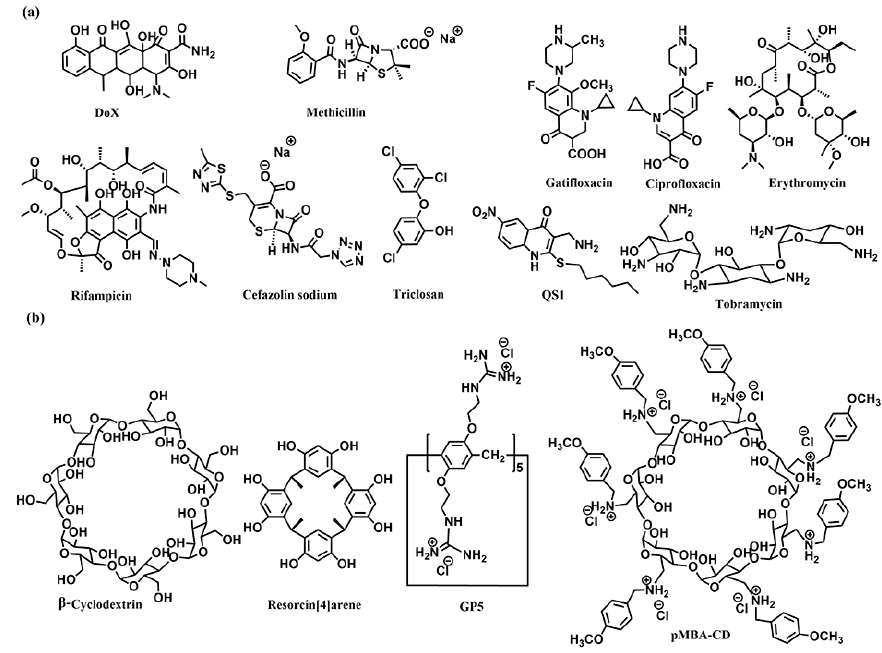
Figure 1. Chemical structures of ( a ) the antibiotics, and ( b ) the co-assembly materials used for fabricating supramolecular self-assembly of antibiotics.